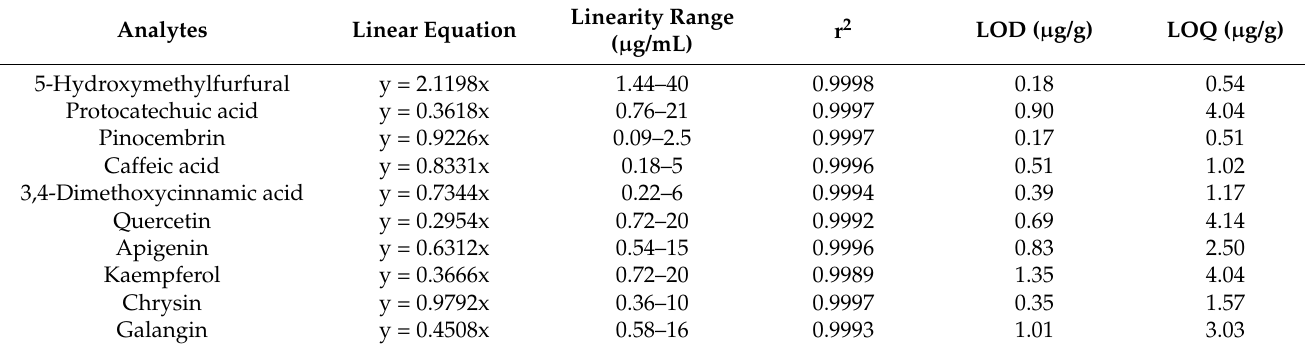
Figure 3. Representative chromatogram of ( a ) standards and ( b ) extractive solution from spiked honey sample. Peak 1, 5-hydroxymethylfurfural; 2, protocatechuic acid; 3, pinocembrin; 4, caffeic acid; 5, 3,4-dimethoxycinnamic acid; 6, quercetin; 7, apigenin; 8, kaempferol; 9, chrysin; 10, galangin; internal standard (IS), coumarin. Table 1. Linearity, LOD, and LOQ of the ten analytes.